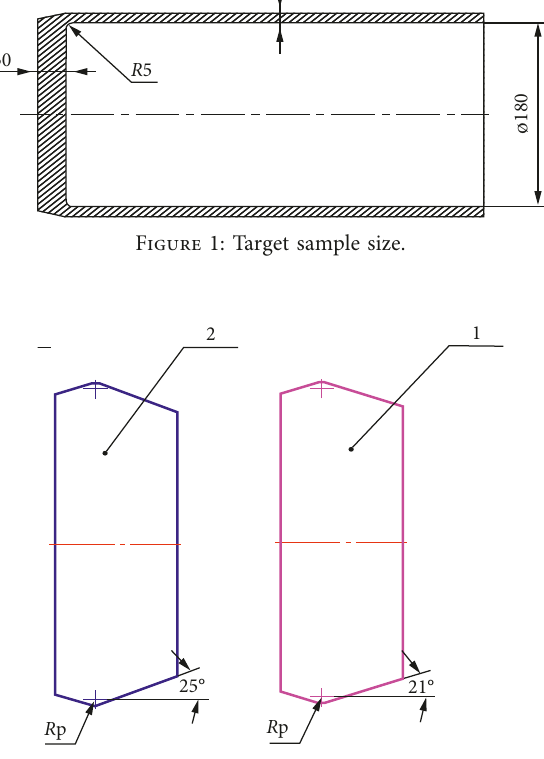
Figure 2: Shape and size of rotary wheels. 1, front wheel; 2, rear wheel.